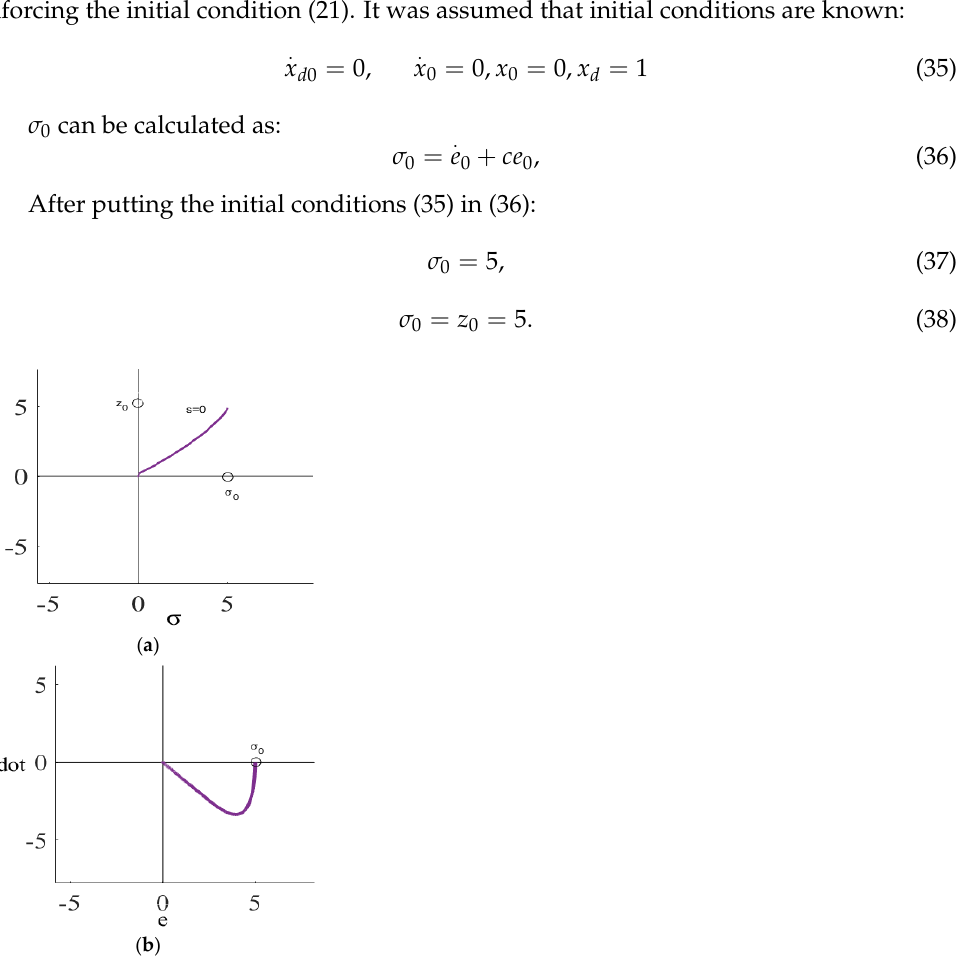
Figure 8. The actual sliding surface of both control schemes.